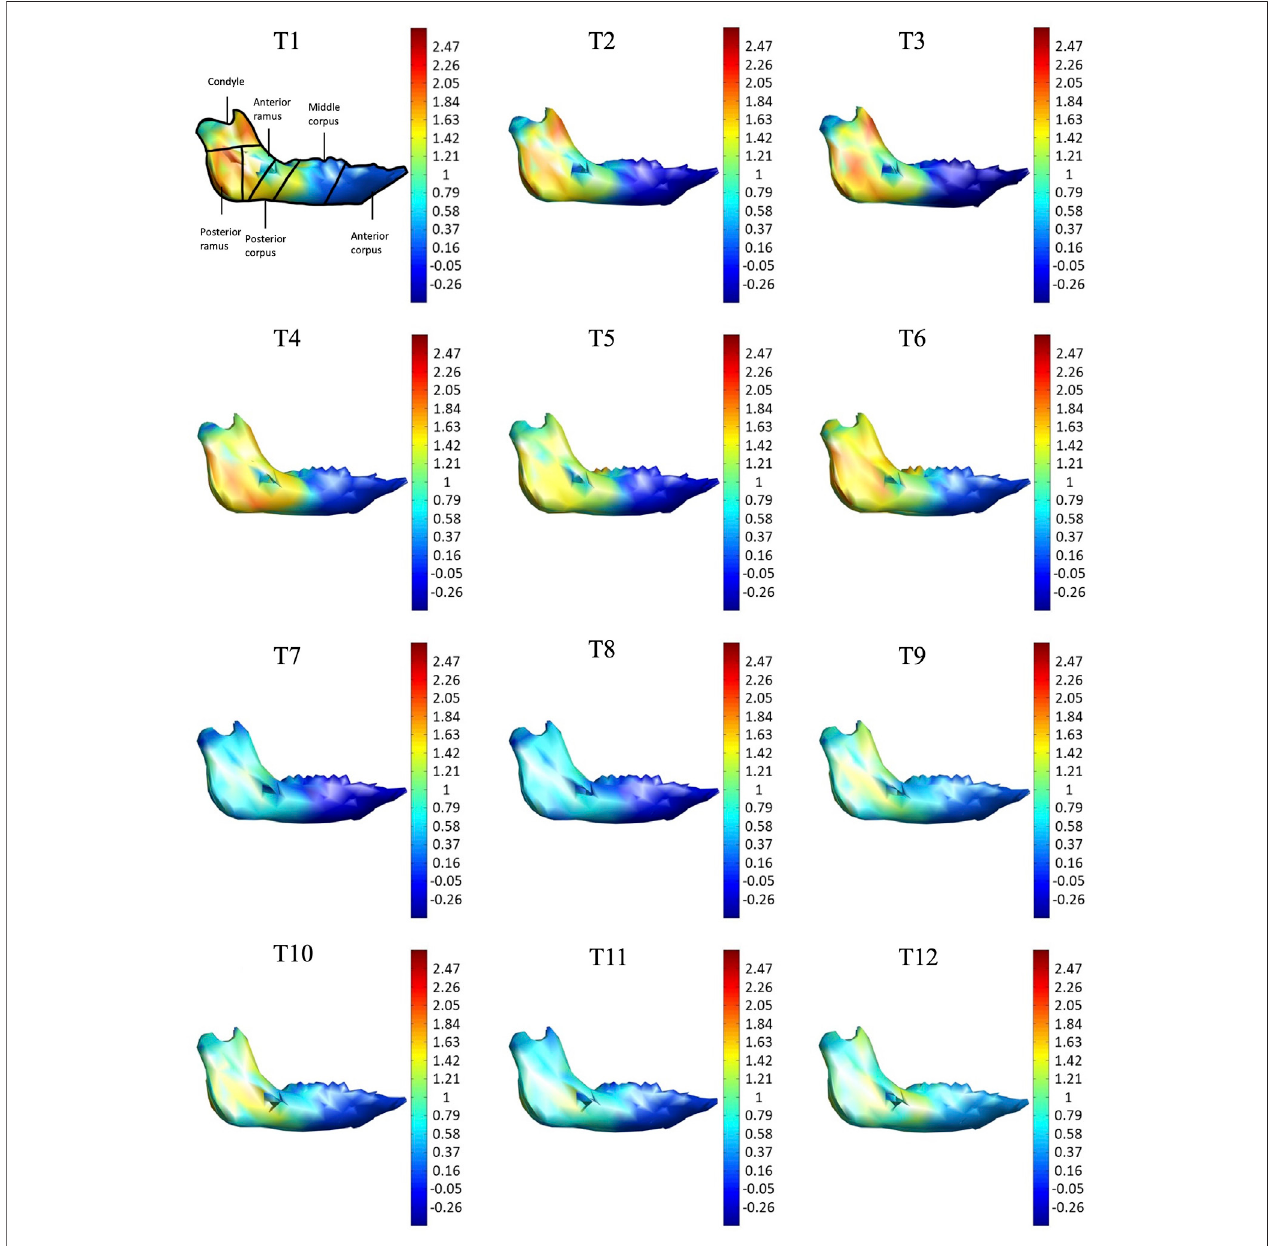
FIGURE5| LateralviewofthemandibleofatypicalsubjectwithmonthlyratesofmorphologicalchangesoverthemandibularsurfaceascolormapsfromT1toT12. The models were scaled to a similar size for better visualization. (unit: %/month).